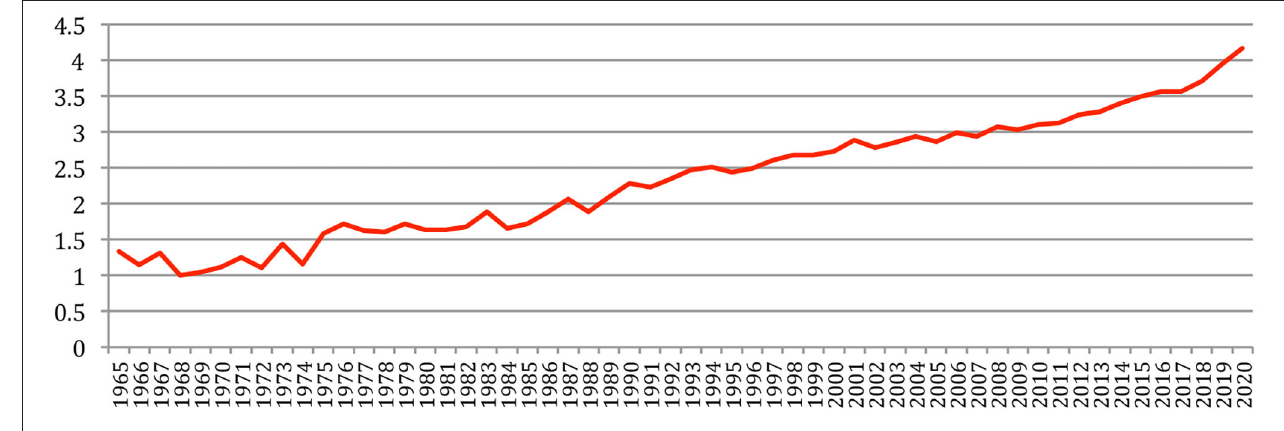
FIGURE 13 | Average number of authors per paper.